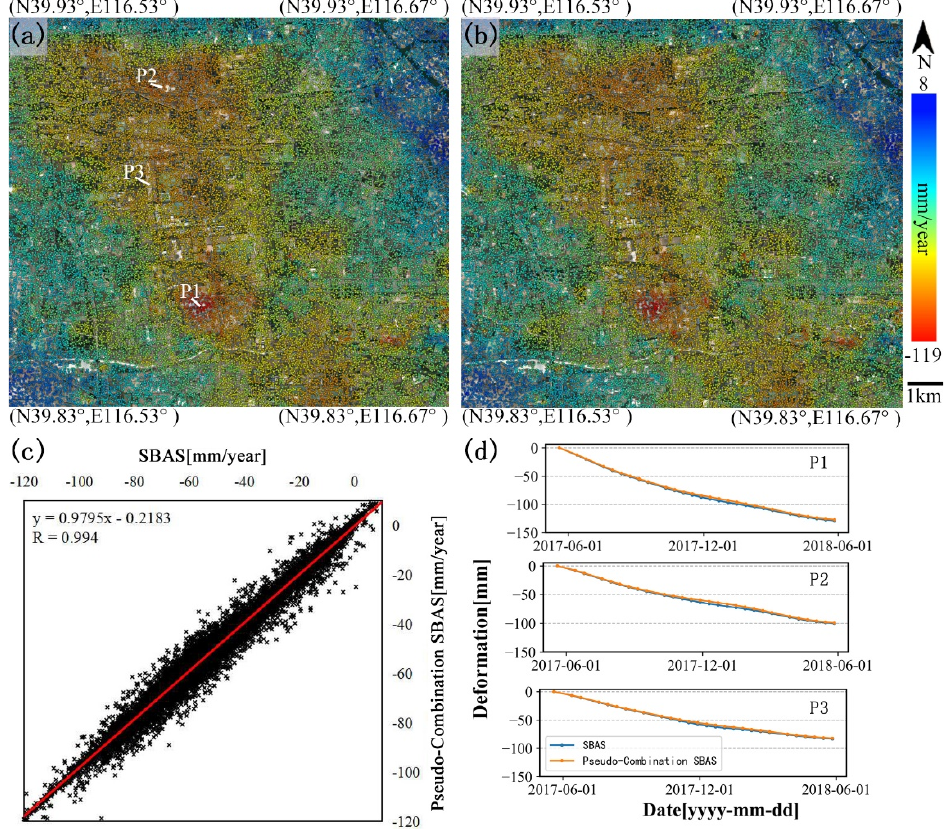
Figure 9. Algorithm performance verification. ( a ) Deformation field calculated by the SBAS algorithm; ( b ) deformation field calculated by the pseudo-combination SBAS algorithm; ( c ) scatter plot of the results of the SBAS and pseudo-combination SBAS algorithms; and ( d ) comparisons of deformation time series at three points.